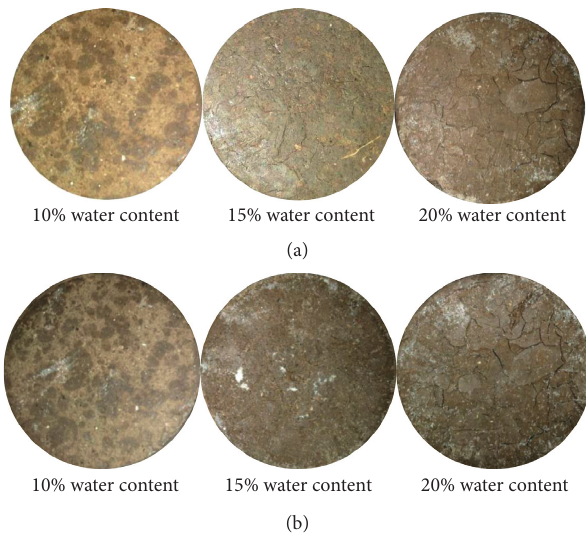
Figure 6: Frost heave cracks on samples with different water